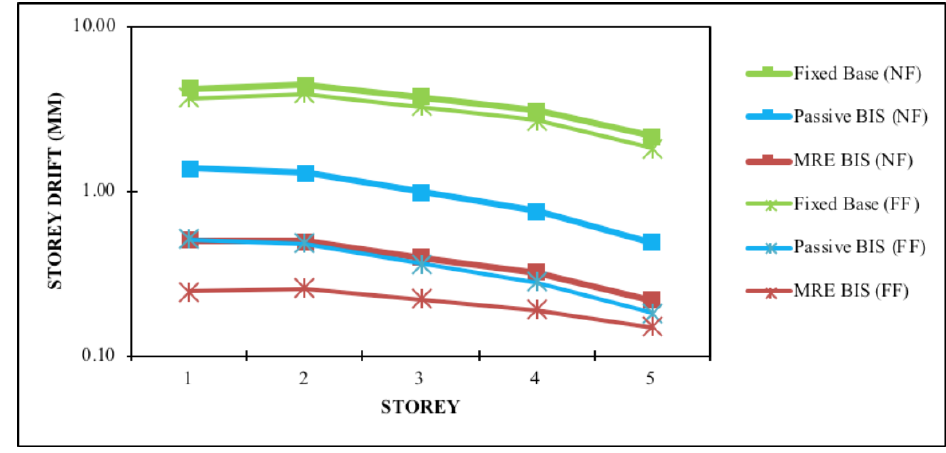
Figure 11. Peak storey drifts, Chi-Chi earthquake.